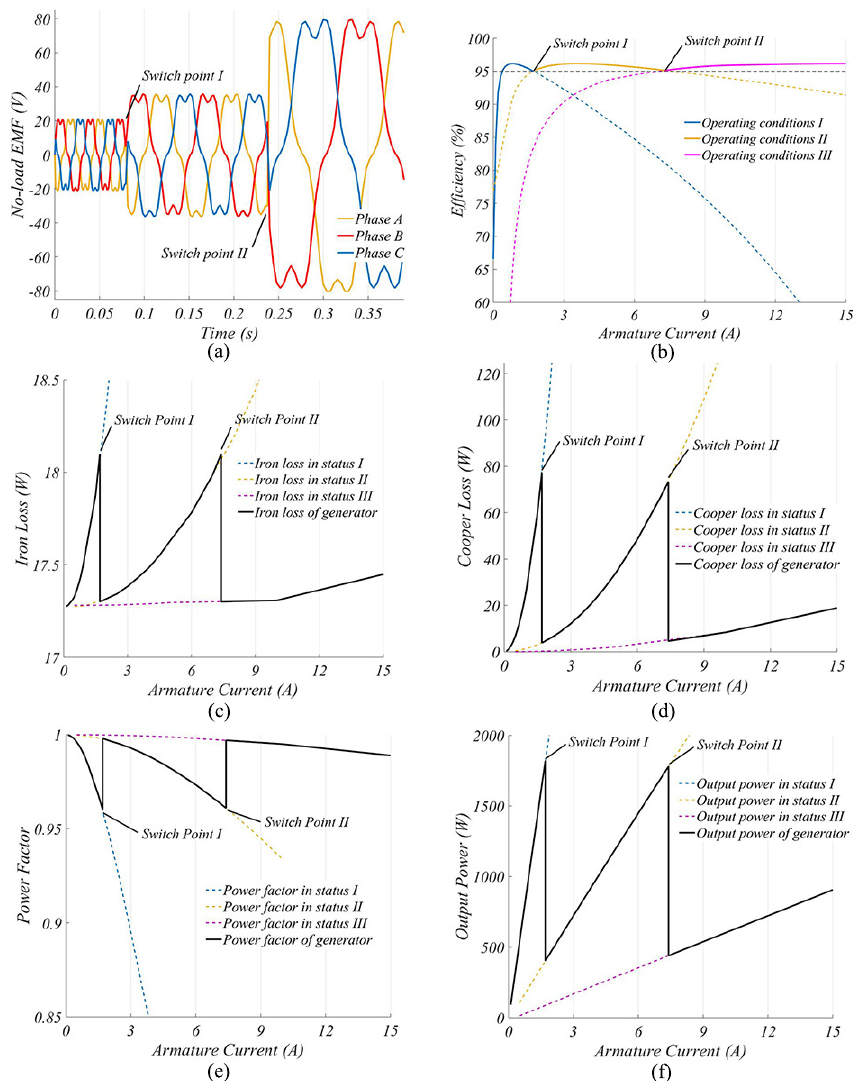
Figure 7. Simulation result of FL the segmented permanent-magnet linear generator. ( a ) No-load EMF; ( b ) Efficiency; ( c ) Copper loss; ( d ) Iron loss; ( e ) Power factor; ( f ) Output